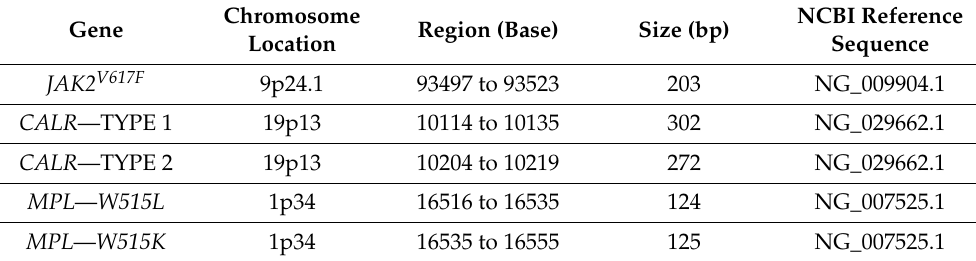
Table A1. Accession numbers of DNA sequences.